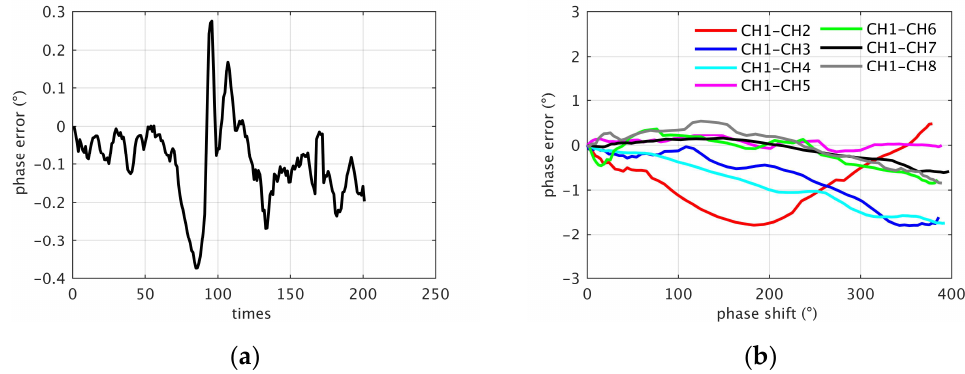
Figure 23. ( a ) Phase measurement error. ( b ) Phase error of channel 1 caused by phase shifter of other channels.